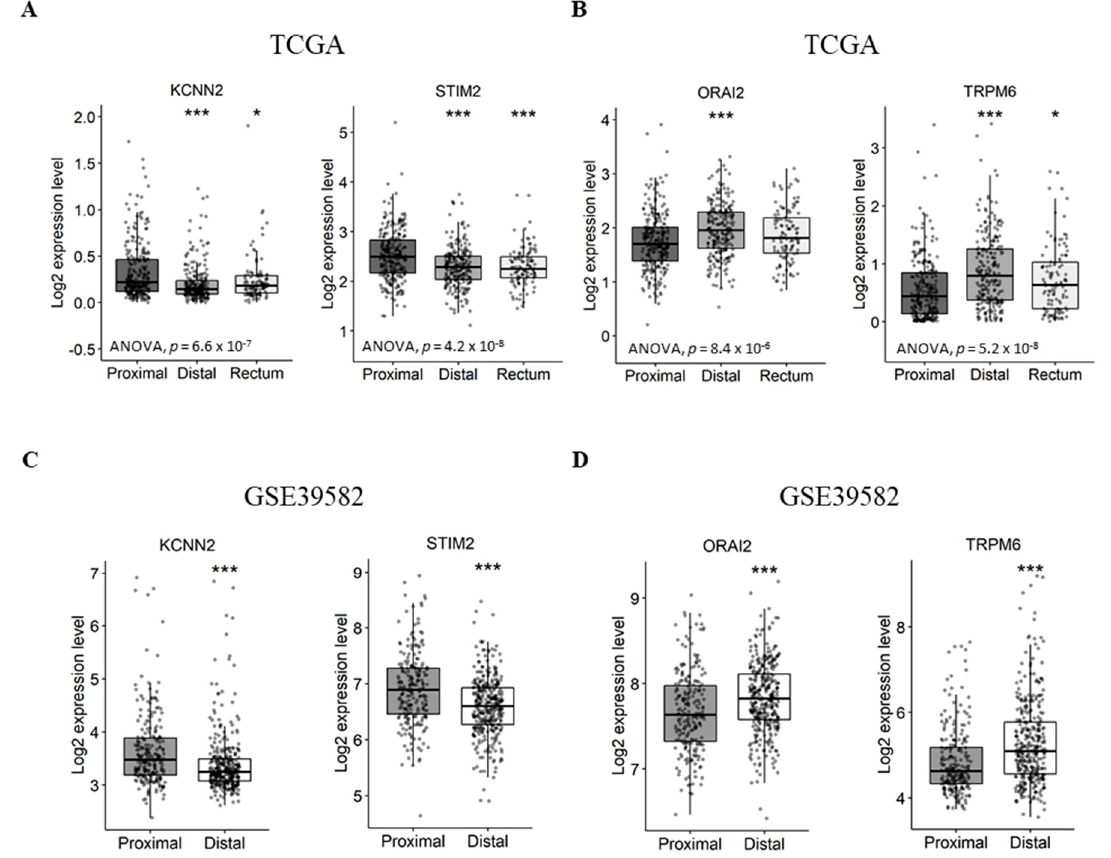
Figure 3. Differentially expressed genes between proximal and distal/rectal tumors in TCGA and GSE39582 datasets. ( A ) Boxplots of genes downregulated in distal/rectal tumors compared to proximal tumors in TCGA. ( B ) Boxplots of genes upregulated in distal/rectal tumors compared to proximal tumors in TCGA. ( C ) Boxplots of genes downregulated in distal tumors compared to proximal tumors in GSE39582. ( D ) Boxplots of genes upregulated in distal tumors compared to proximal tumors in GSE39582. ANOVA test was used for multiple comparisonsThe student’s t -test was used for pairwise comparison. (* p < 0.05; *** p < 0.001). ANOVA: analysis of variance; TCGA: The Cancer Genome Atlas.